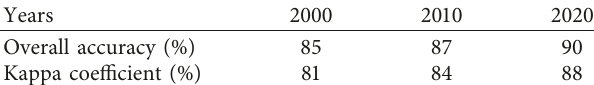
Table 2: Evaluation of LULC classification accuracy.